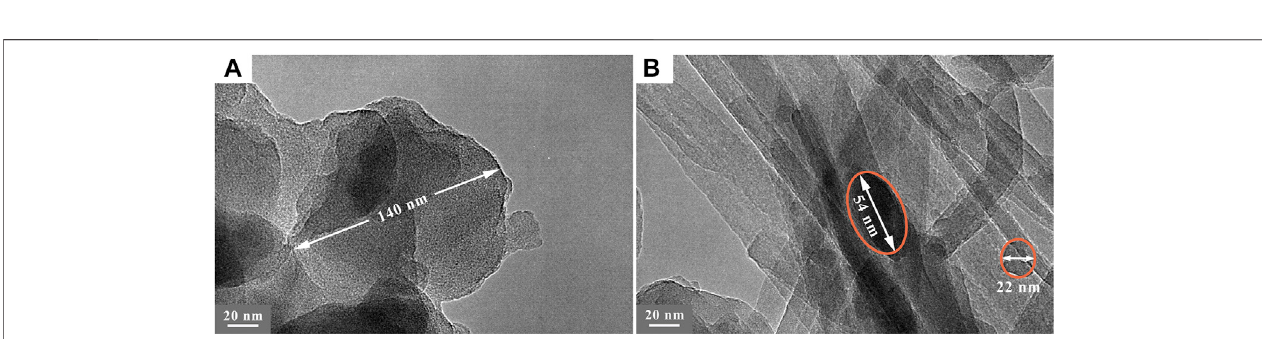
FIGURE 3 | TEM images of (A) nZVI and (B) nZVI/SEP